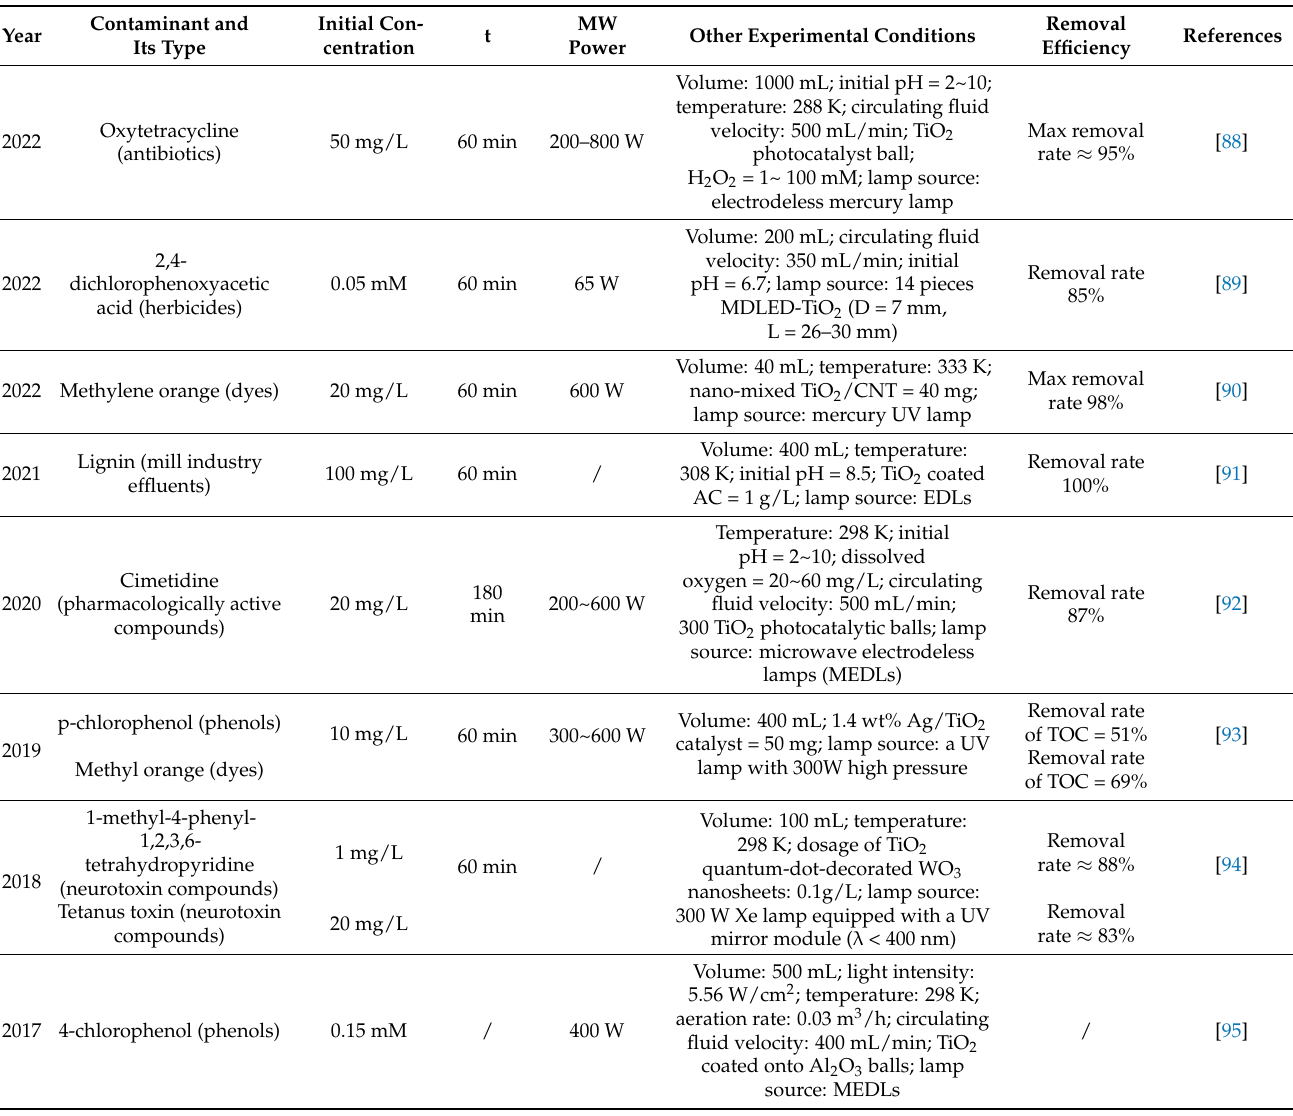
Table 1. List of studies on the removal of aqueous organic contamination with MW/UV/TiO 2 photocatalysis 1